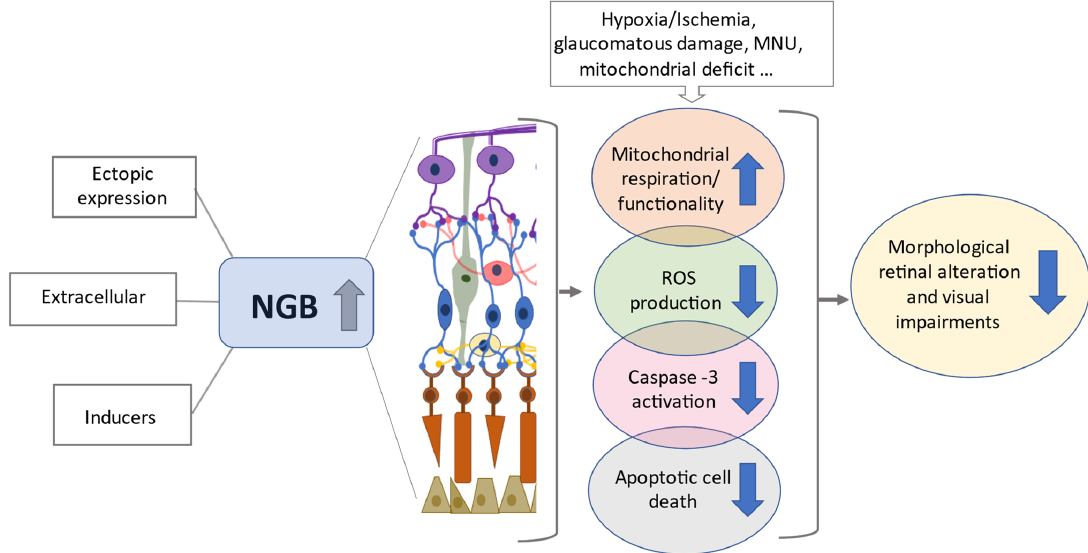
Figure 2. High levels of NGB prevent retinal degeneration. The increase in NGB protein levels in retinal layers due to ectopic overexpression, direct treatment with exogenous NGB or with inducers of intracellular NGB (e.g., hemin), promotes mitochondrial functionality, attenuates oxidative stress and apoptotic cell death (e.g., photoreceptor cells, retinal ganglion cells), preserving, in turn, the visual function under stressing and/or neurodegenerative conditions. For details, see the text. Reactive oxygen species (ROS), N -Methyl-N-nitrosourea (MNU).